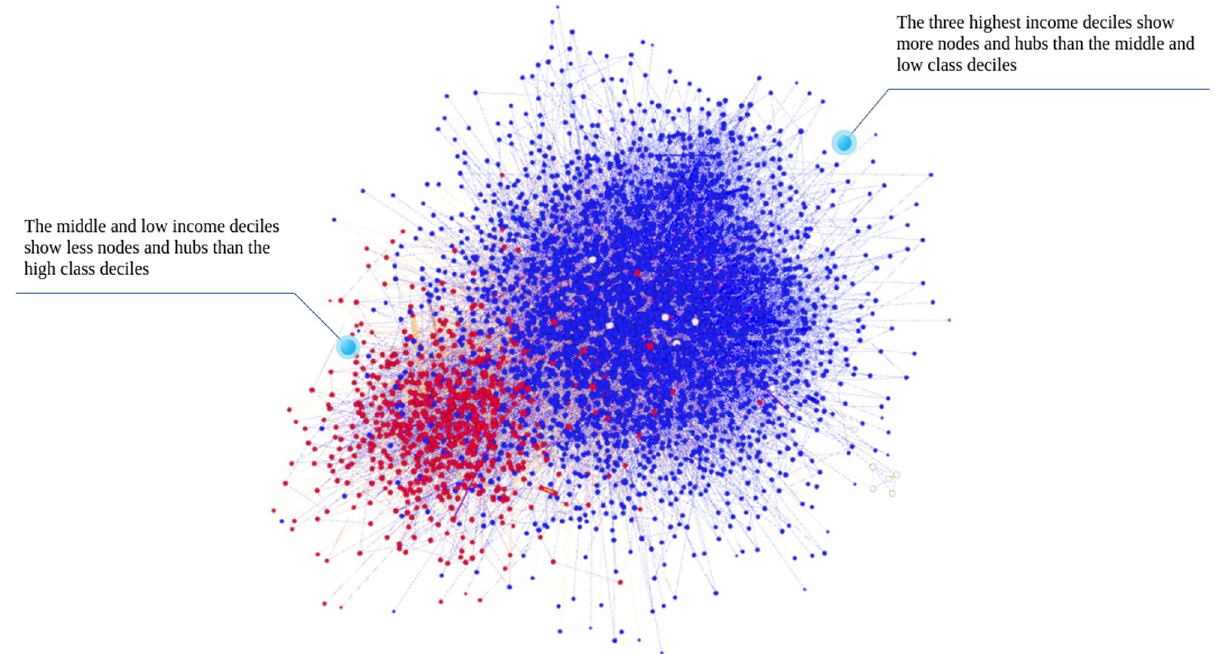
Fig 2. A visualization of SA19k. SA19k is highly modular, with modularity score = 0.802. Low-middle, and high-income deciles are grouped into two modularity-based partitions. The blank nodes do not belong to any of them. Low-middle income distribution deciles (in red color) show less nodes and hubs than the rest of the network. High income deciles (in blue color) show more nodes and hubs than the rest of the network. The size of each node represents its degree.